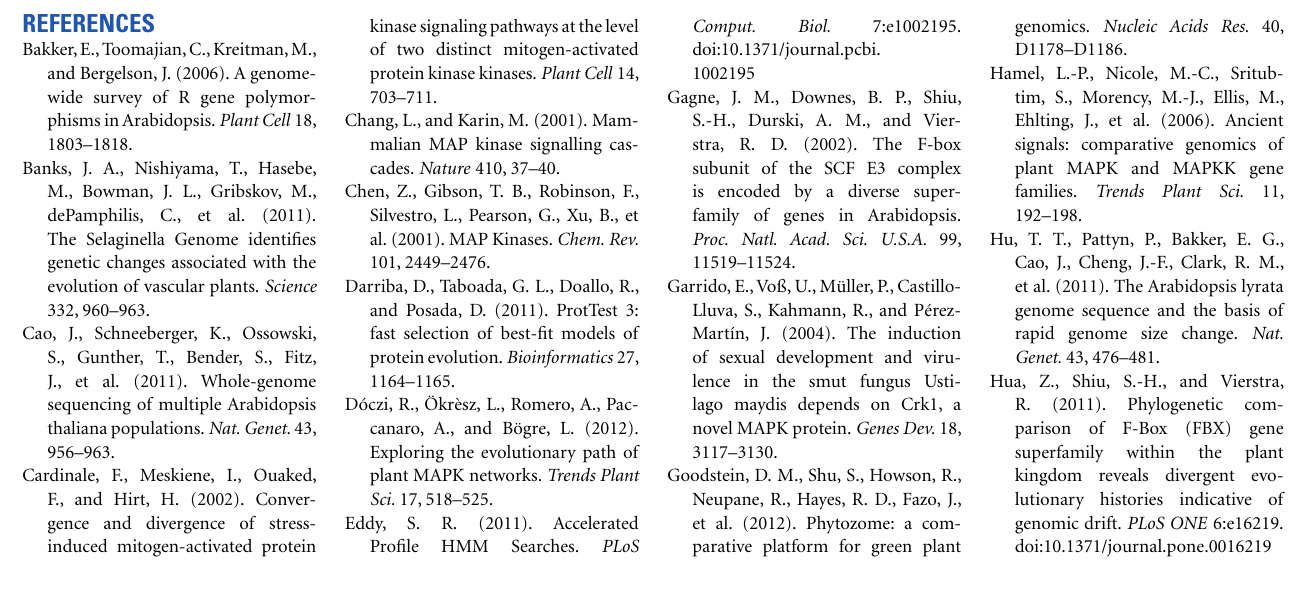
Table S1 | Major types of MAPKs in plant genomes. Genes may have multiple names according to different publications. Figure S1 | Linear phylogeny of plant MAPKs and MAPK-likes. Linear display of the circular Bayesian tree in Figure 2 .The colored icons correspond to the different species. Posterior probabilities are indicated at the respective nodes. The monocot clade and the PP sequence with the atypical MEY activation loop within theTEY-B clade are marked by asterisks. Exon-intron structures of that part of each gene that was in the alignment were plotted next to each gene; blue boxes, exon; red boxes, 5 (cid:48) -UTR; yellow boxes, 3 (cid:48) -UTR. Figure S2 | Sliding window plots of sequence divergence between MAPKs and MAPK-likes in Arabidopsis thaliana and Arabidopsis lyrata . For sliding window analysis, nucleotide sequences of AT (indicated by Arabidopsis Genome Initiative identifier) and homologous nucleotide sequences of AL were used.Window size was 51bp, and step size was 9bp.The black arrows in the plots denotes the position of theTxY activation